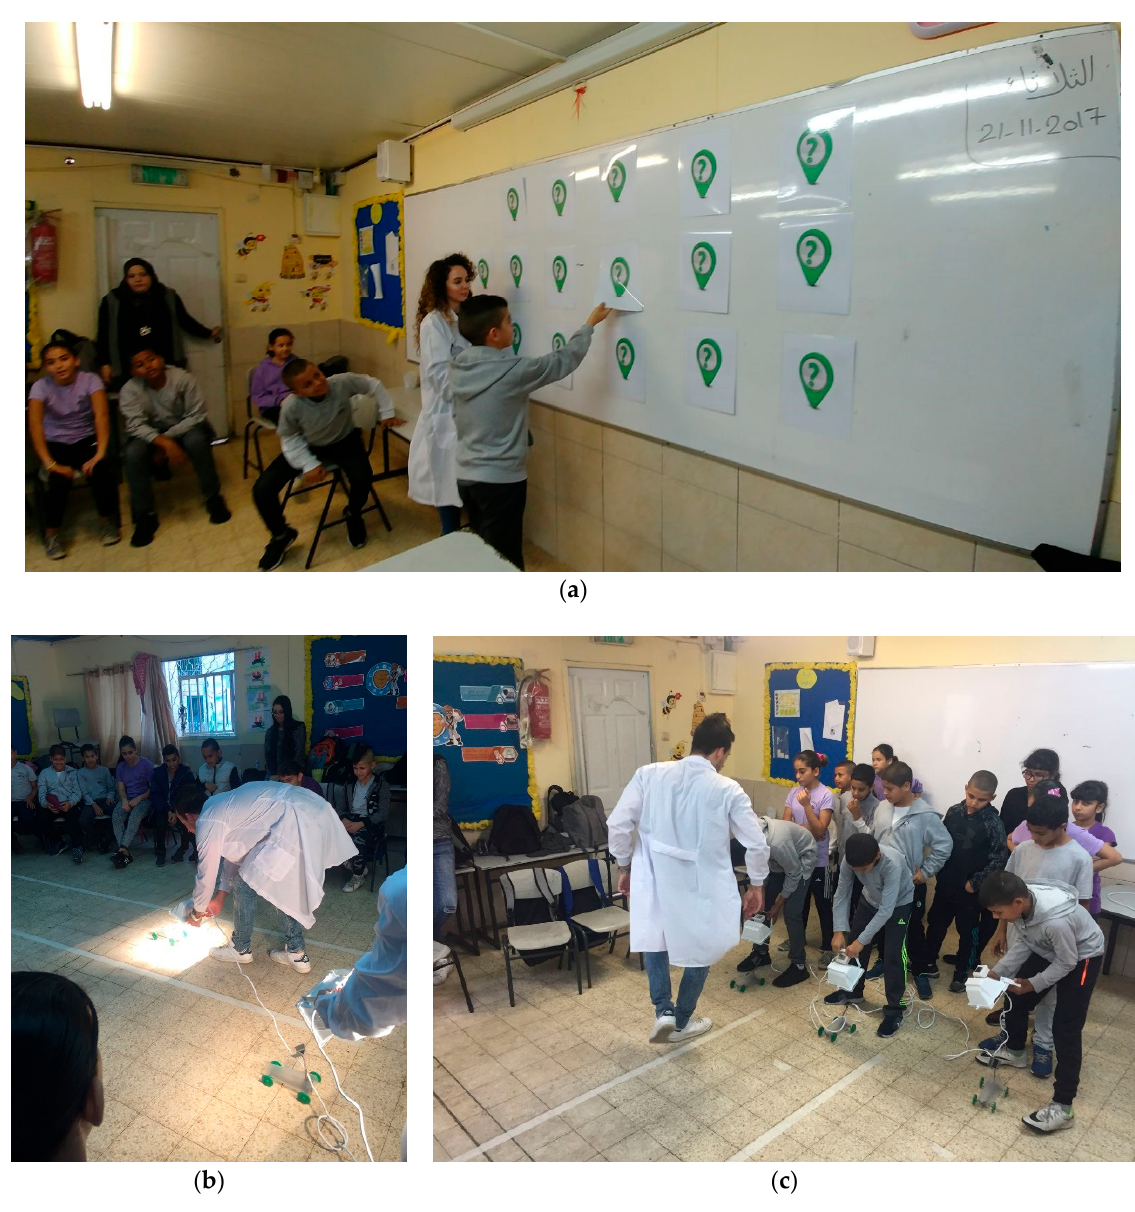
Figure 2. ( a ) Memory game about types of energy presented by the “Renewable energy group”; ( b , c ) Solar class race. The pupils were asked to start them by a moveable light source.